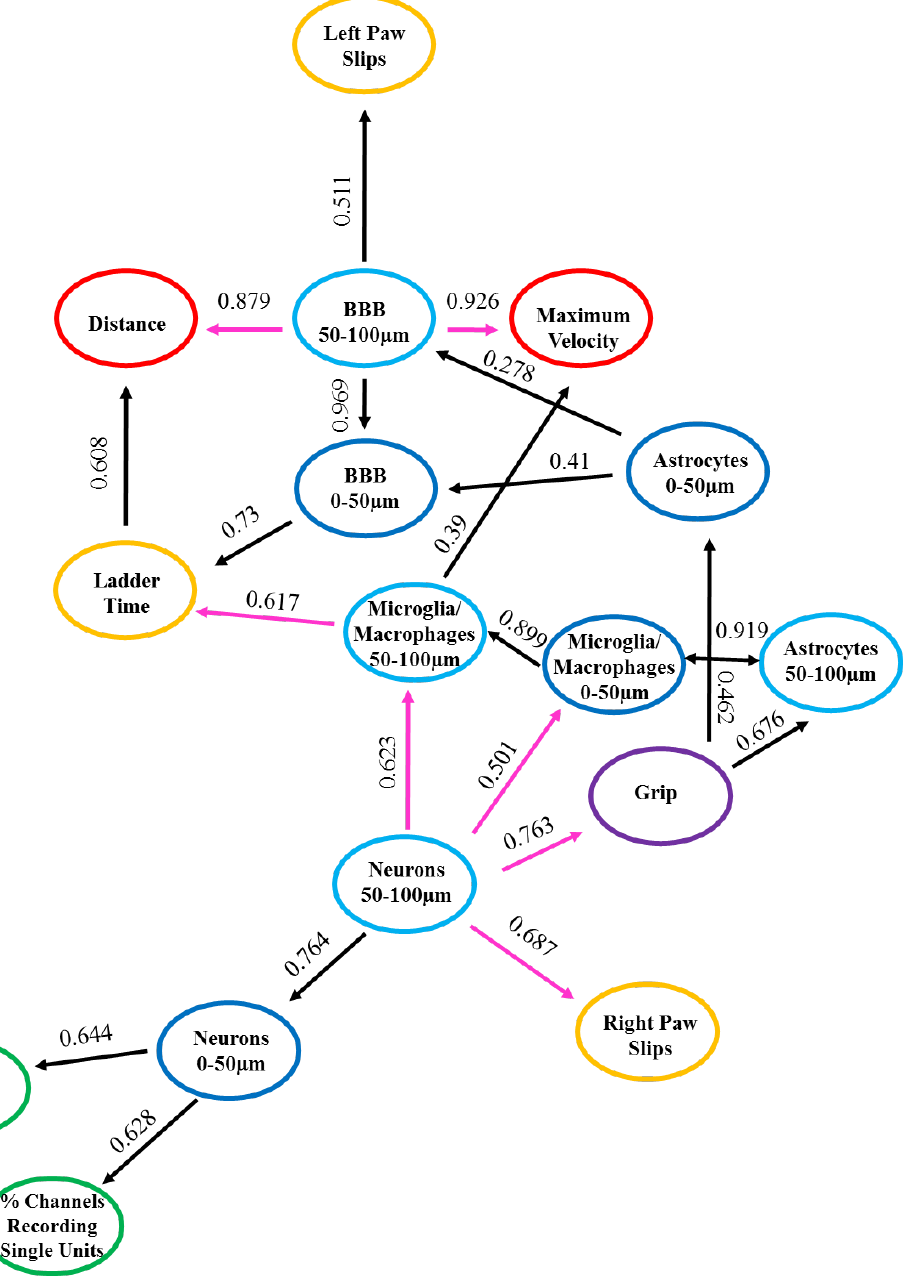
Figure 4. Associations with Positive and Negative Relationships. Graphical representation depicting the positive (in black color) and negative (in magenta color) relationships between the measured variables. n = 6.